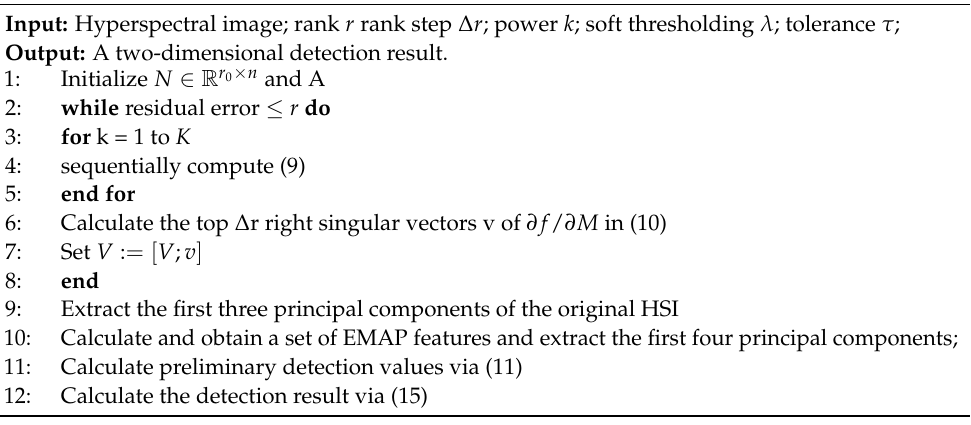
Algorithm 1. GBSAED framework for hyperspectral anomaly